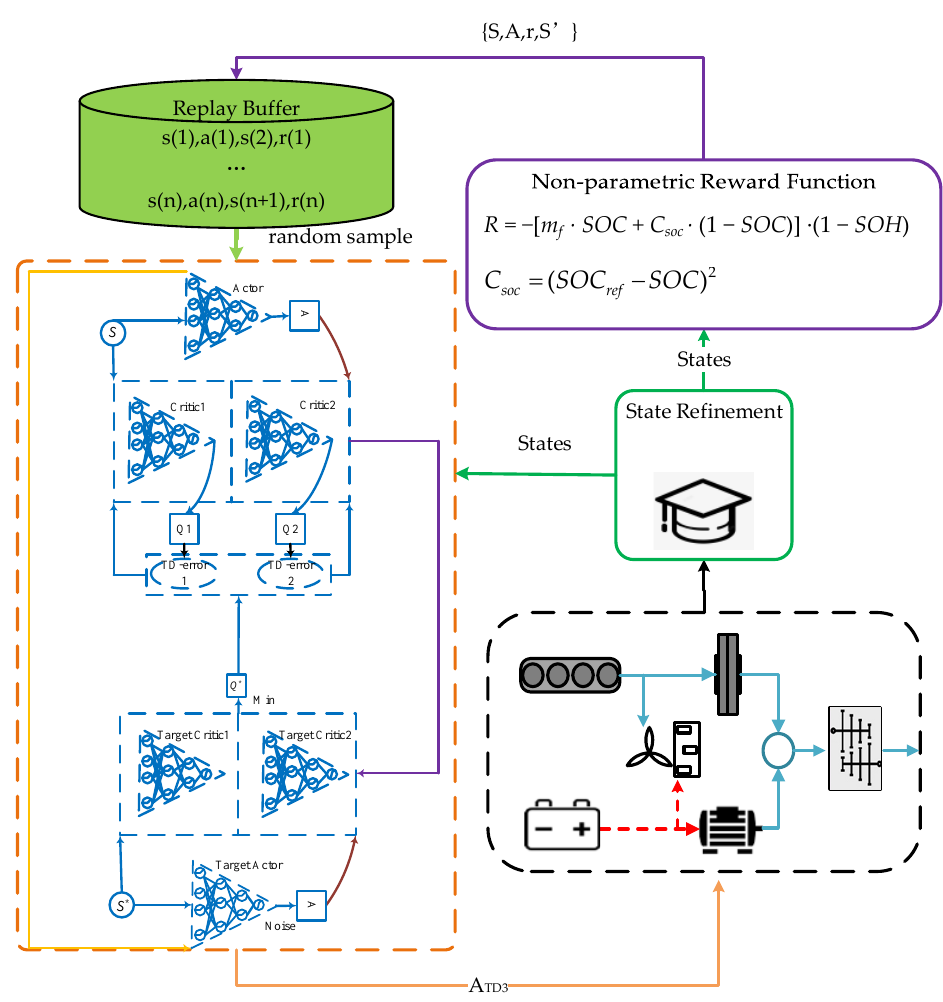
Figure 3. The architecture of NPR-TD3 based strategy.